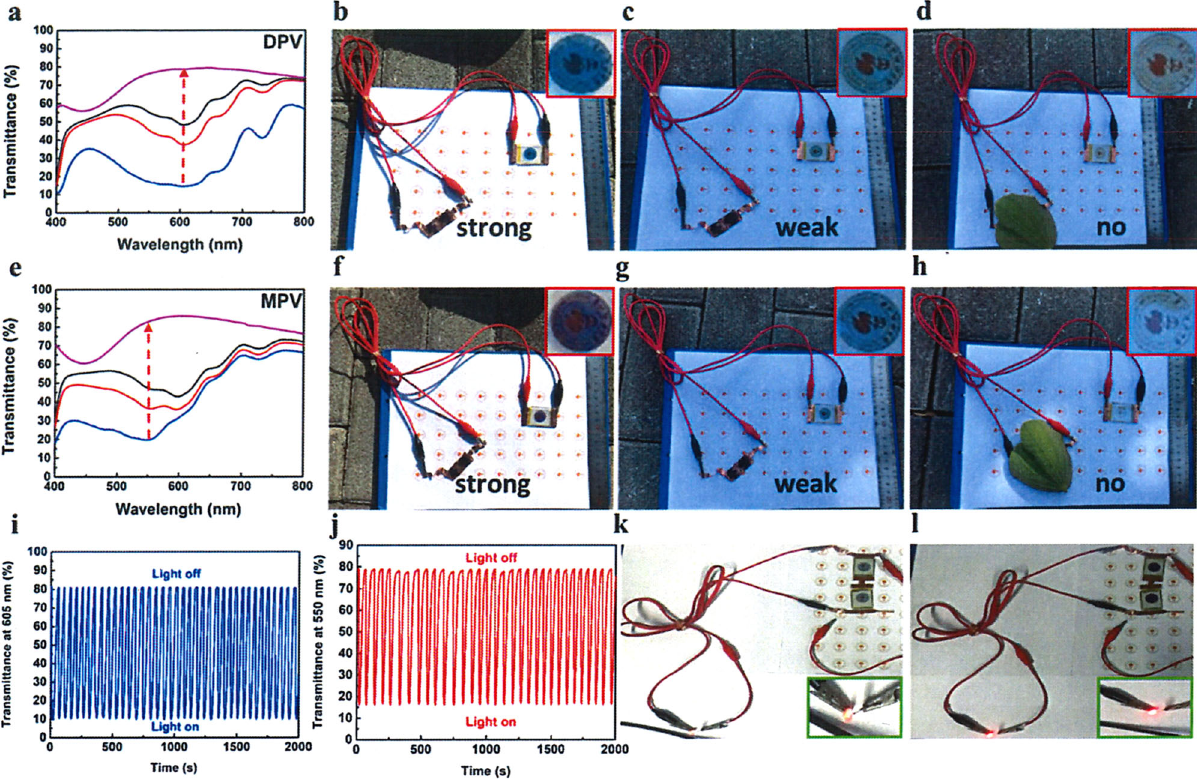
Fig. 4 Performances of PSC-powered ECS based on DPV and MPV. UV-visible spectra of ECDs powered by two connected PSCs with decreased light density for DPV ( a ) and MPV ( e ); PSCs powered ECD in natural surrounding with strong light, weak light, and no light ( b , c , d for DPV-based ECD and f , g , h for MPV-based ECD); transmittance switching tests under strong light and no light of PSC-powered ECD at maximum absorption ( i : DPV, j : MPV); lighting LED by two connected ECDs ( k DPV, l